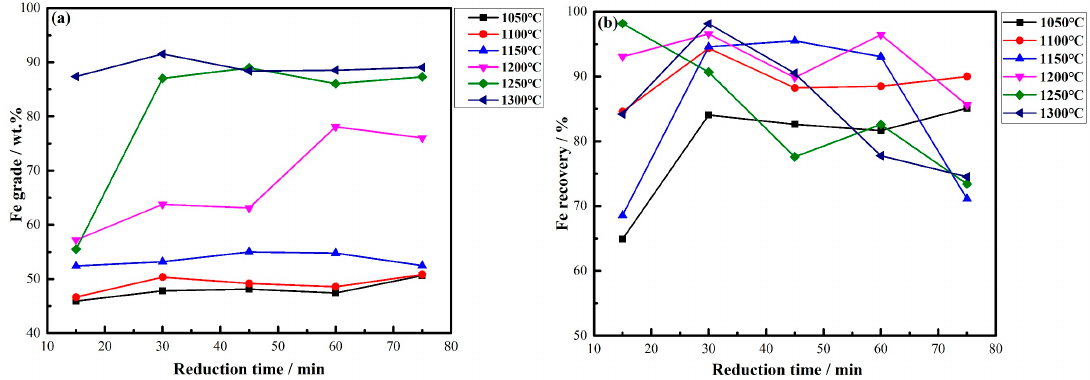
Figure 7. The effect of reduction temperature and time on Fe grade ( a ) and recovery ( b ). Figure 7. The e ff ect of reduction temperature and time on Fe grade ( a ) and recovery ( b